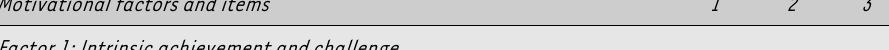
TABLE 2: Results of factor analysis of motives for participating in the Comrades Marathon (‘up’ and ‘down’ runs) Motivational factors and items